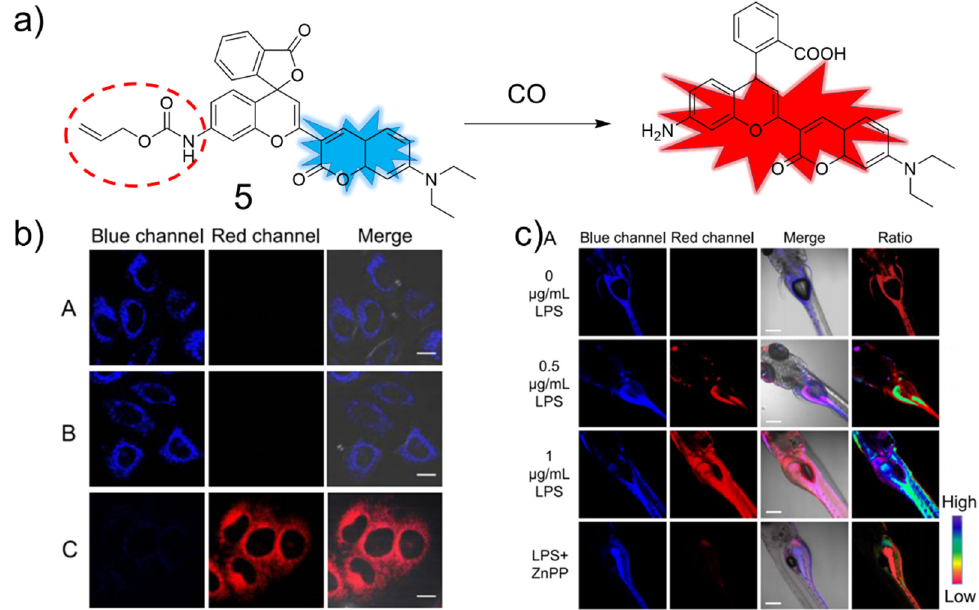
Figure 5. ( a ). The chemical structure of probe 5 and the response mechanism toward CO. ( b , c ) The fluorescent images of 5 for detecting endogenous CO in HepG2 cells and zebrafish. Copyright (2021) Elsevier ltd. [22].